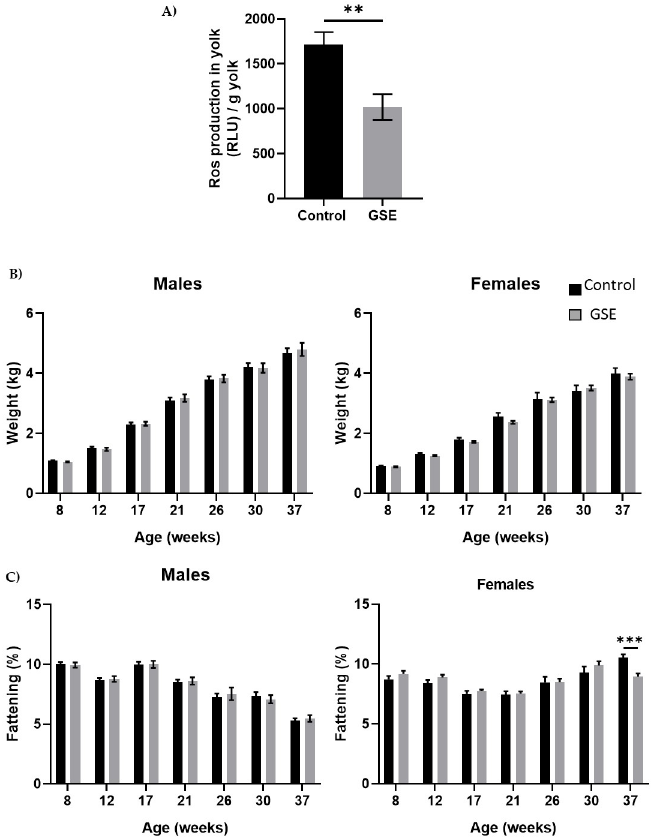
Fig 1. Growth curve. (A ) Level of Reactive Oxygen Species (ROS, H 2 0 2 ) in egg yolk of broiler hens fed 1% GSE dietary supplementation (n = 10 egg yolks analysed per group). Results are expressed in Relative Luminescent Units per gram of yolk. (B) Live body weight of males (left panel) and females (right panel) from 8 to 37 weeks of age (n = 20). Animals were weighed every 4 weeks. (C) Fattening level in male (left panel) and female (right panel) broilers was assessed by CT scan from 8 to 37 weeks of age (n = 10 animals/sex). Results are presented as means ± SEM. P values were considered significant if �� , p < 0.01. ��� , p < 0.001.